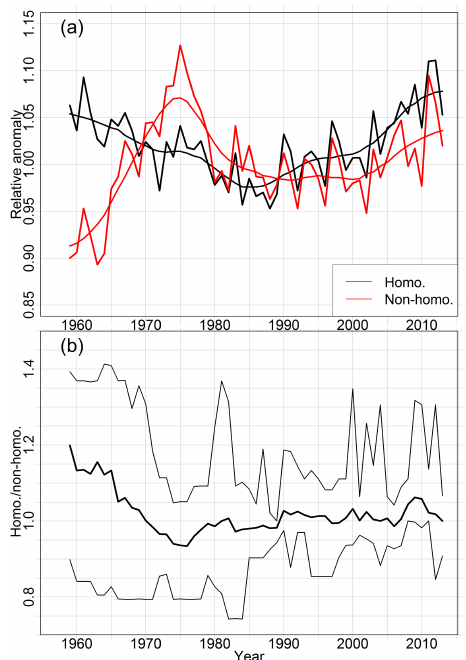
Figure 3. (a) Average annual Italian SSR series plotted together with an 11-year window, 3-year standard deviation Gaussian low- pass filter before (red line) and after (black line) the homogenization procedure; (b) mean annual adjustment series is obtained by calcu- lating the annual average adjustment over all series (bold line). The figure also shows the maximum range in the